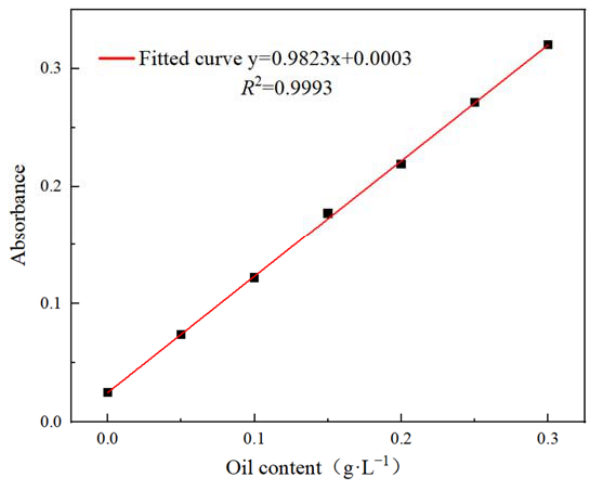
Figure 2. Standard curve of the oil.